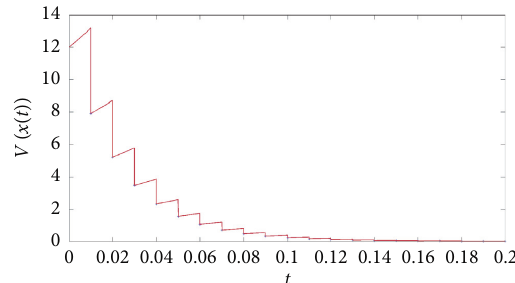
Figure 10: The trajectory of the finite-time Lyapunov function V of system (36) with the coefficients a � 35, b � ( 8/3 ) , c � 25, t � 0 . 01 k ( k � 1 , 2 , ... , ) , d k ( i � 1 , 2 , 3 ) and the initial condition x ( 0 ) � ( 3 , 4 , 5 ) T